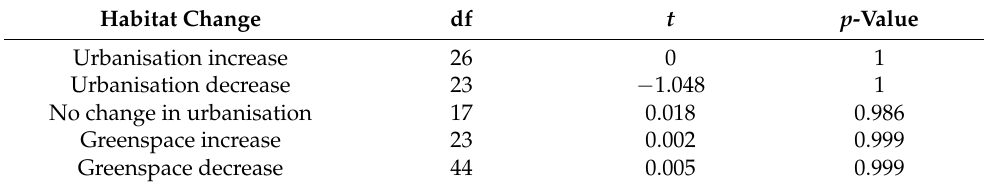
Table 7. Results of paired t -test for difference in the proportion of feeding specialisation in bird assemblages with changing land